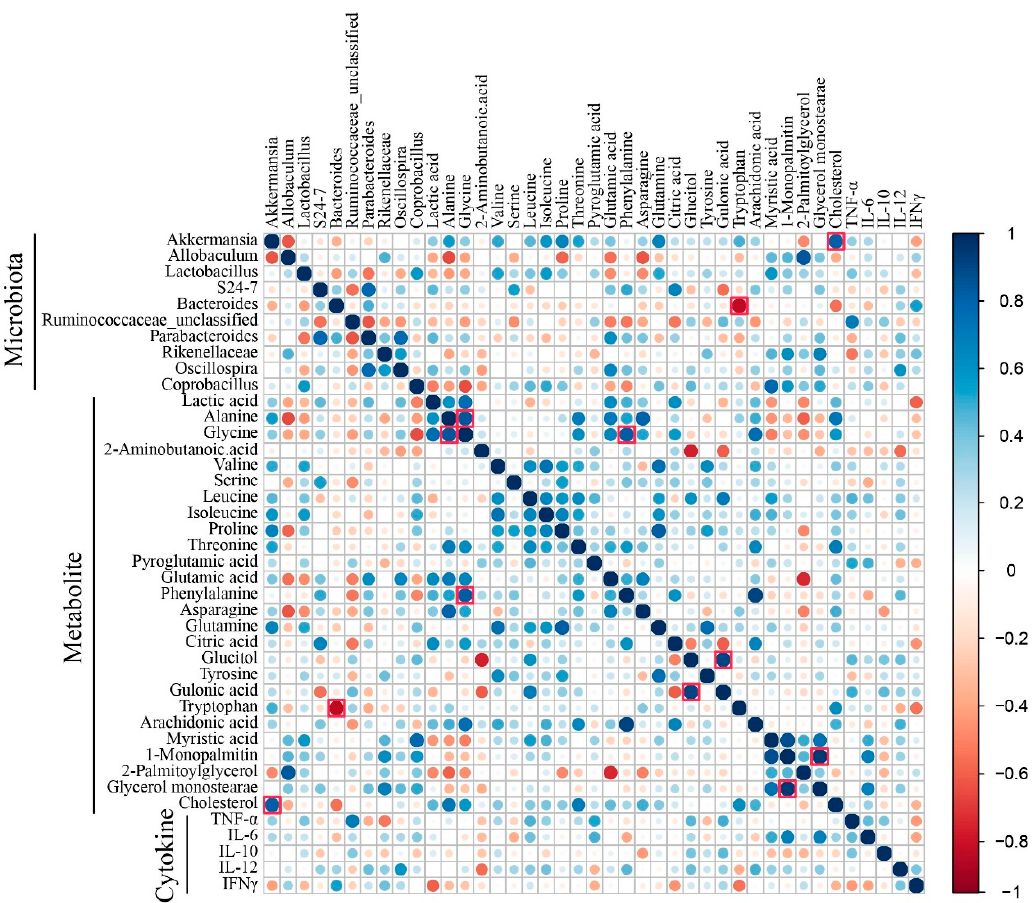
Figure 6. Heat map derived from the correlations among the altered gut microbiota, disturbed metabolites in serum, and changed cytokine levels. The correlation matrixes were formed based on Spearman’s rank correlation coefficients. The correlation coefficients greater than 0.8 in the heat map were indicated by red square borders.